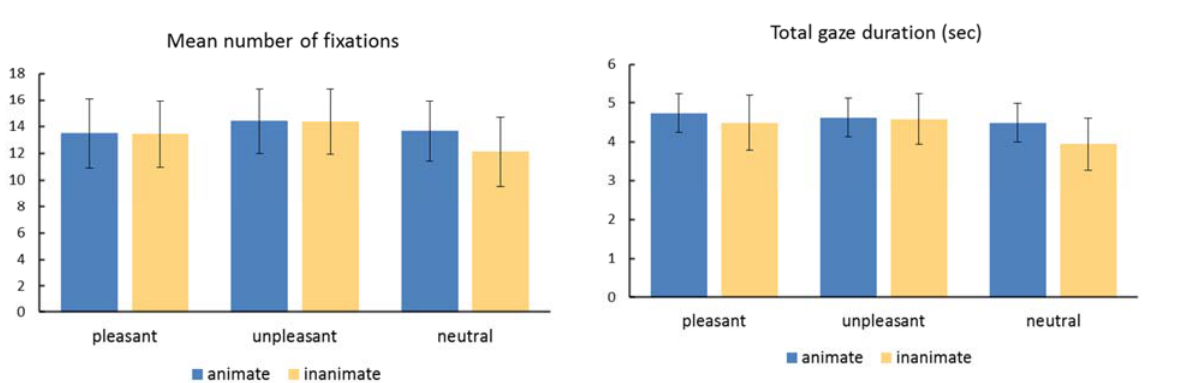
Figure 3 - Mean of total gaze duration for animate vs. inan- imate pictures within each valence category. Vertical bars indi- cate standard